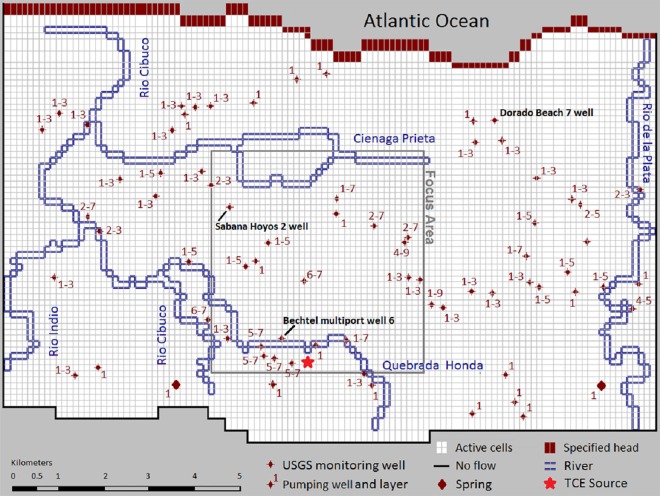
The model domain and defined boundaries.The domain extends beyond the two rivers and consists of focus area, location of TCE source, springs, USGS monitoring wells, and groundwater extraction wells. The well labels indicate the range of layers from which the groundwater was extracted.